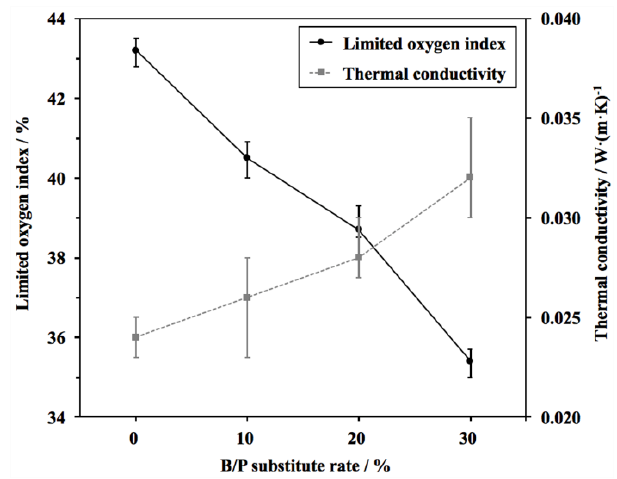
Figure 3. Limited oxygen index and thermal conducticity of PF and BPFs.